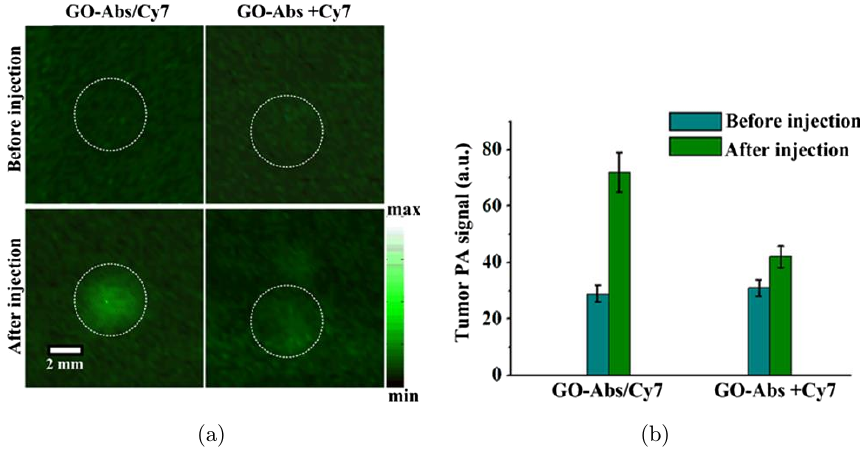
Fig. 6. Comparison of PAI contrast of tumors after being injected with GO – Abs/Cy7, GO – Abs and Cy7. (a) The ¯rst group of U87-bearing Balb/c nude mice ( n ¼ 3) was injected through the tail vein (IV) with GO – Abs/Cy7 (the ¯rst row). In the second group ( n ¼ 3), separate GO – Abs and Cy7 solutions were injected simultaneously into the same mice (the second row). The PAI in the ¯rst line represents the mouse group before injection and the second line represents the mouse 6 h after being injected with GO- Abs/Cy7 or GO-Abs plus Cy7. The white dotted lines on the images illustrate the approximate tumor edges. (b) Quanti¯cation of the signals in the tumor shows higher in the PA image after injecting GO-Abs/Cy7 compared to before injection and in the other group (the injection of GO-Abs and Cy7 in the same mouse). The error bars represent standard error ( n ¼ 3 mice).